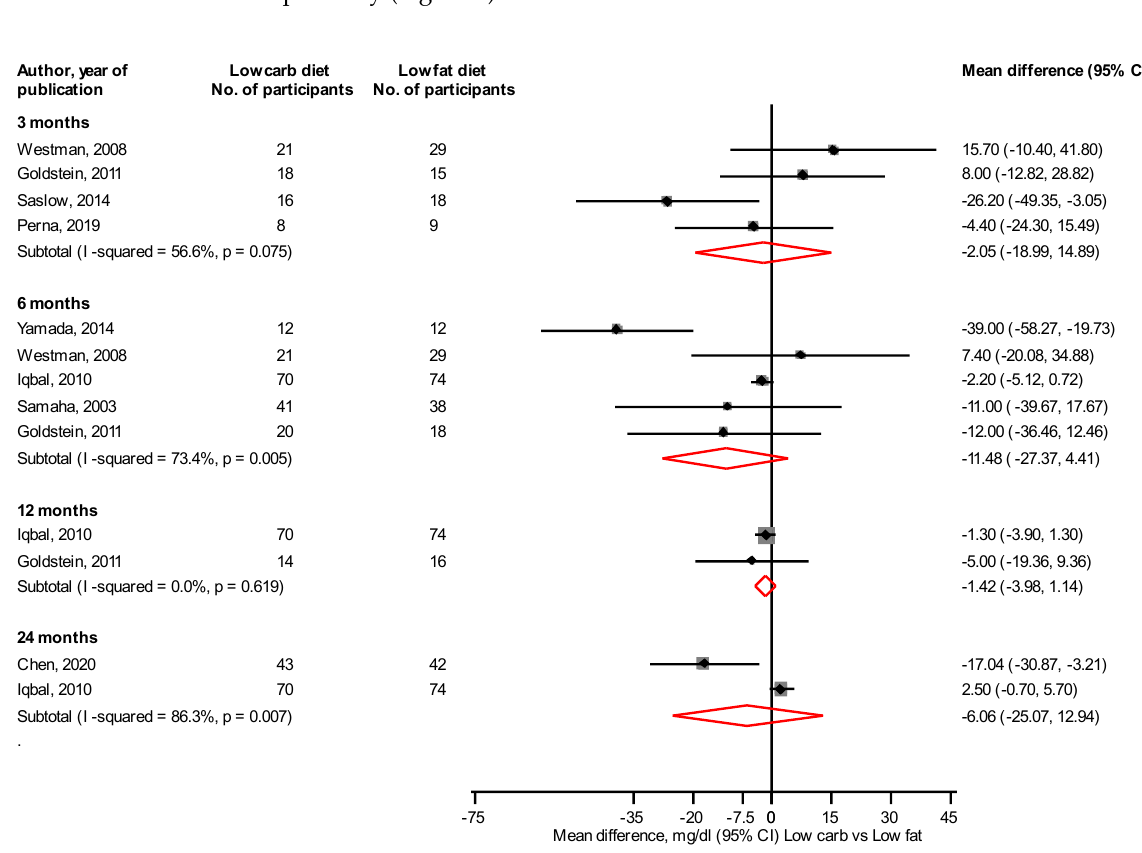
Figure 2. Low carbohydrate versus low fat diet and fasting glucose levels [31,34,36,41 – 43,50,51].